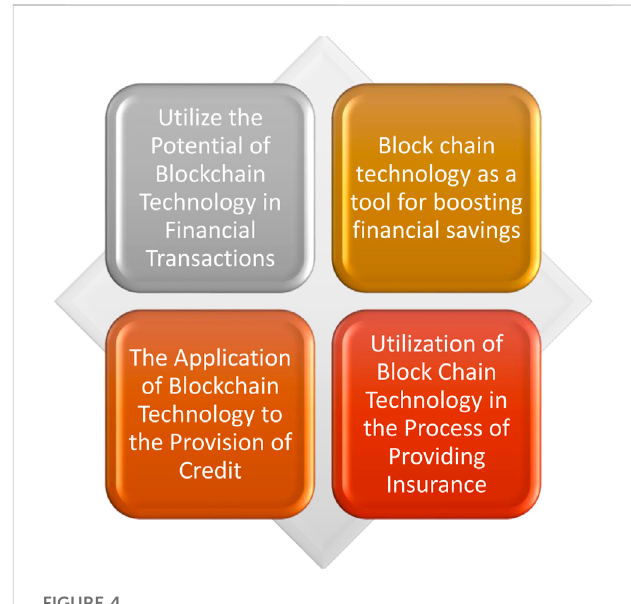
FIGURE 4 Strategies for broadening access to fi nancial services using